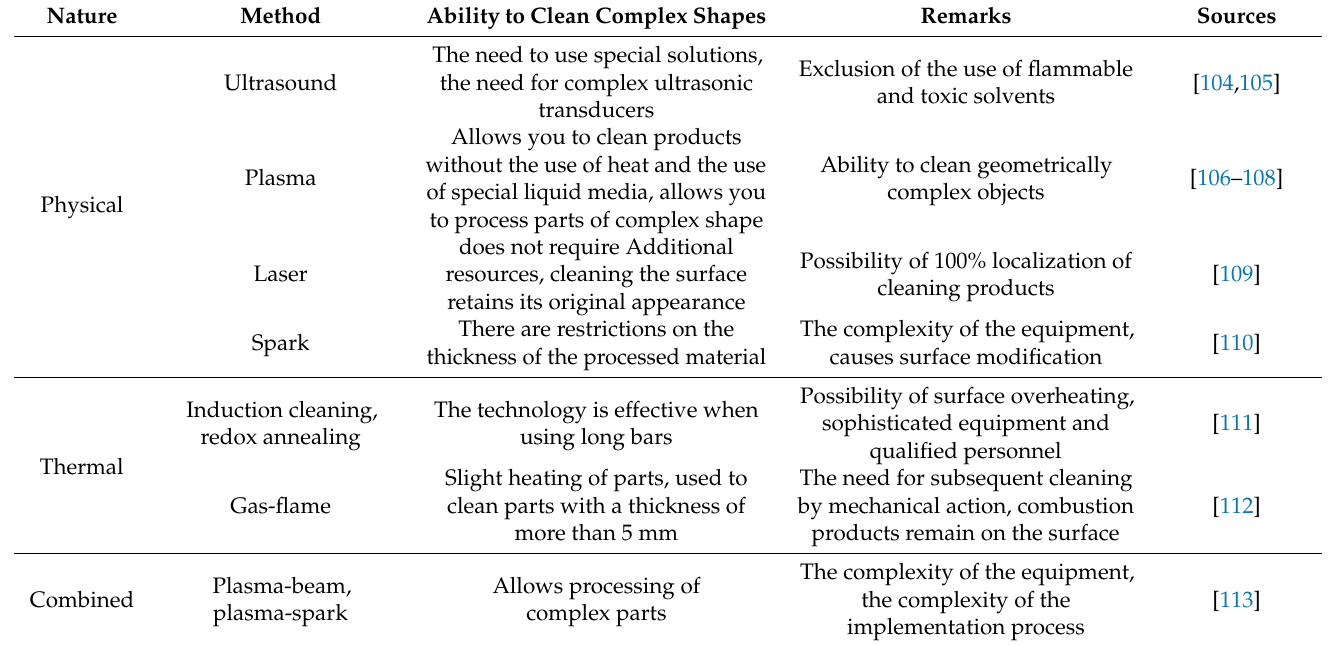
Table 3. Methods for removing the oxide